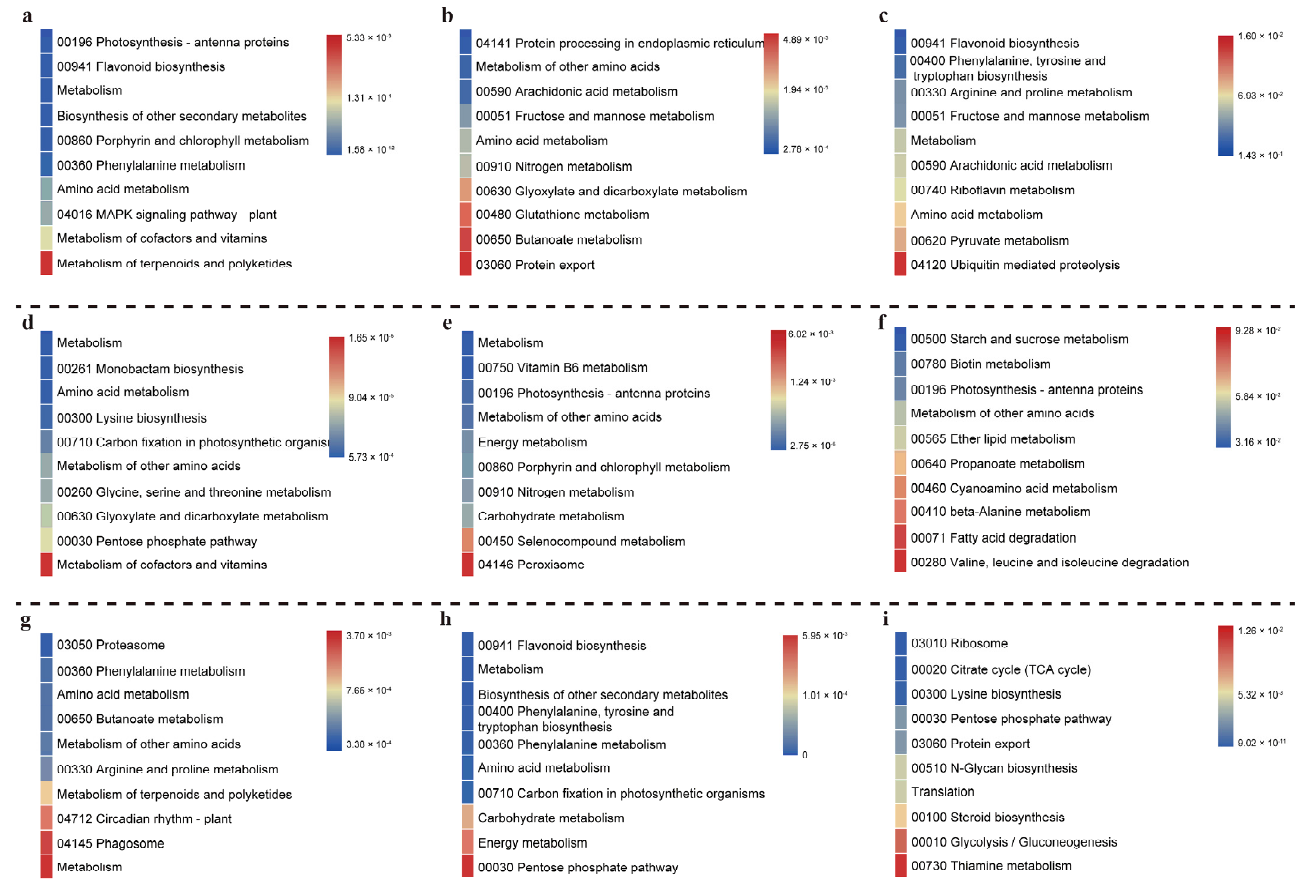
Figure 3. The KEGG pathway enrichment statistics in the modules of PEG and salinity treatments. ( a – d ), the top 10 KEGG pathways in the blue, brown, yellow, and turquoise modules of PEG treat- ments. ( e – i ), the top 10 KEGG pathways in the blue, green, brown, yellow, and turquoise modules of salinity treatments.